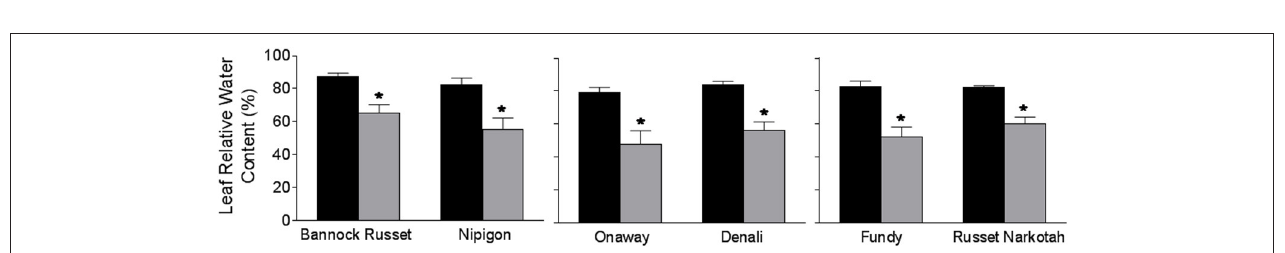
FIGURE 2 | Leaf relative water content (RWC) of six potato genotypes grown under well-watered and drought conditions. RWC was estimated on the fully expanded terminal leaflets of 5-week-old well-watered plants or drought-stressed plants (analyzed after 6 days of withholding watering). The data represent the averages of three experiments ± SE. Significant differences of the means between well-watered and drought-stressed plants within each cultivar are indicated by the symbol * ( P ≤ 0.05).